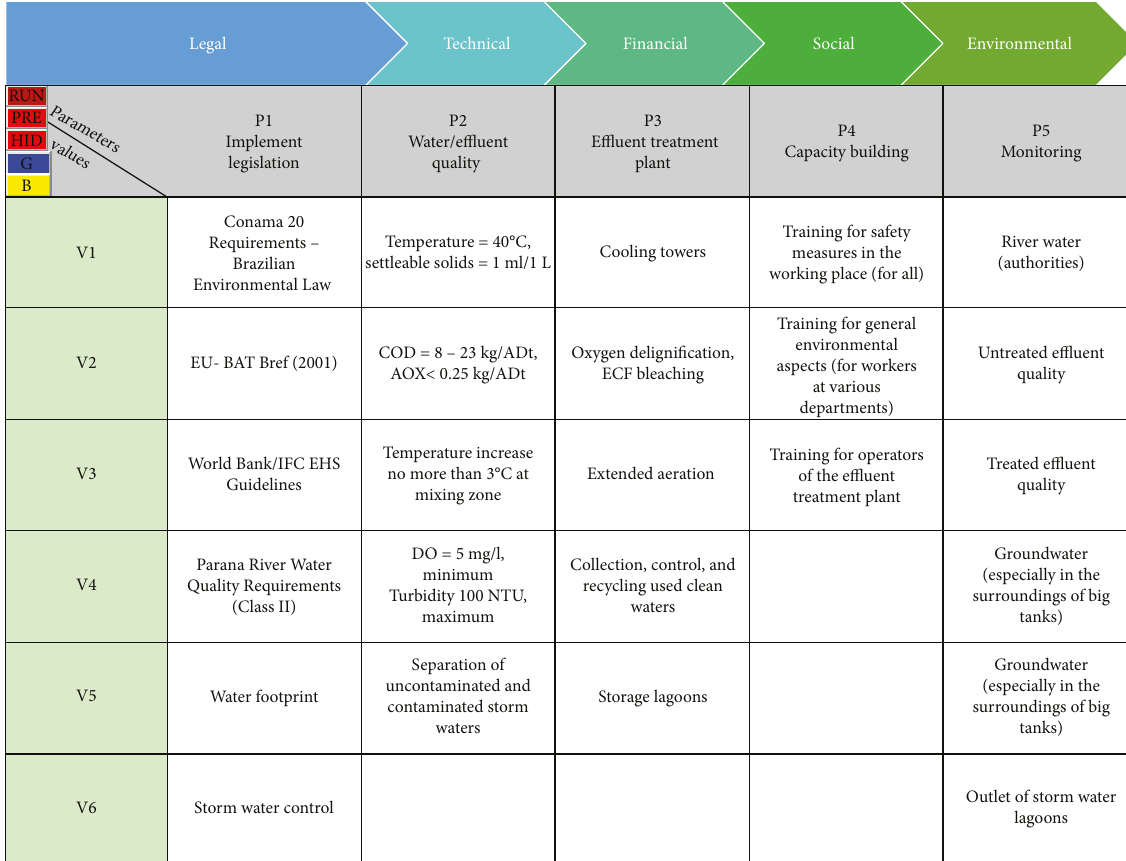
Figure 2: Development of the morphological fi eld with fi ve parameters and their values. BAT: Best Available Technology; IFC EHS: International Finance Corporation Environmental Health and Safety; COD: chemical oxygen demand; ADt: air dry tons; AOX: absorbable halogen compounds; DO: dissolved oxygen concentration; NTU: nephelometric turbidity unit; ECF: elemental chlorine free; Conama: Conselho Nacional do Meio Table 2: Combinations of parameters/values. Parameters Values P 1